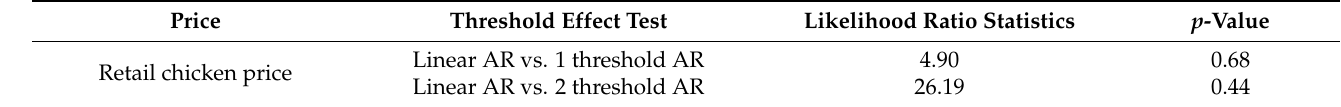
Table 6. Threshold Effect Test of Avian Influenza-related News on Retail Chicken Prices. Price